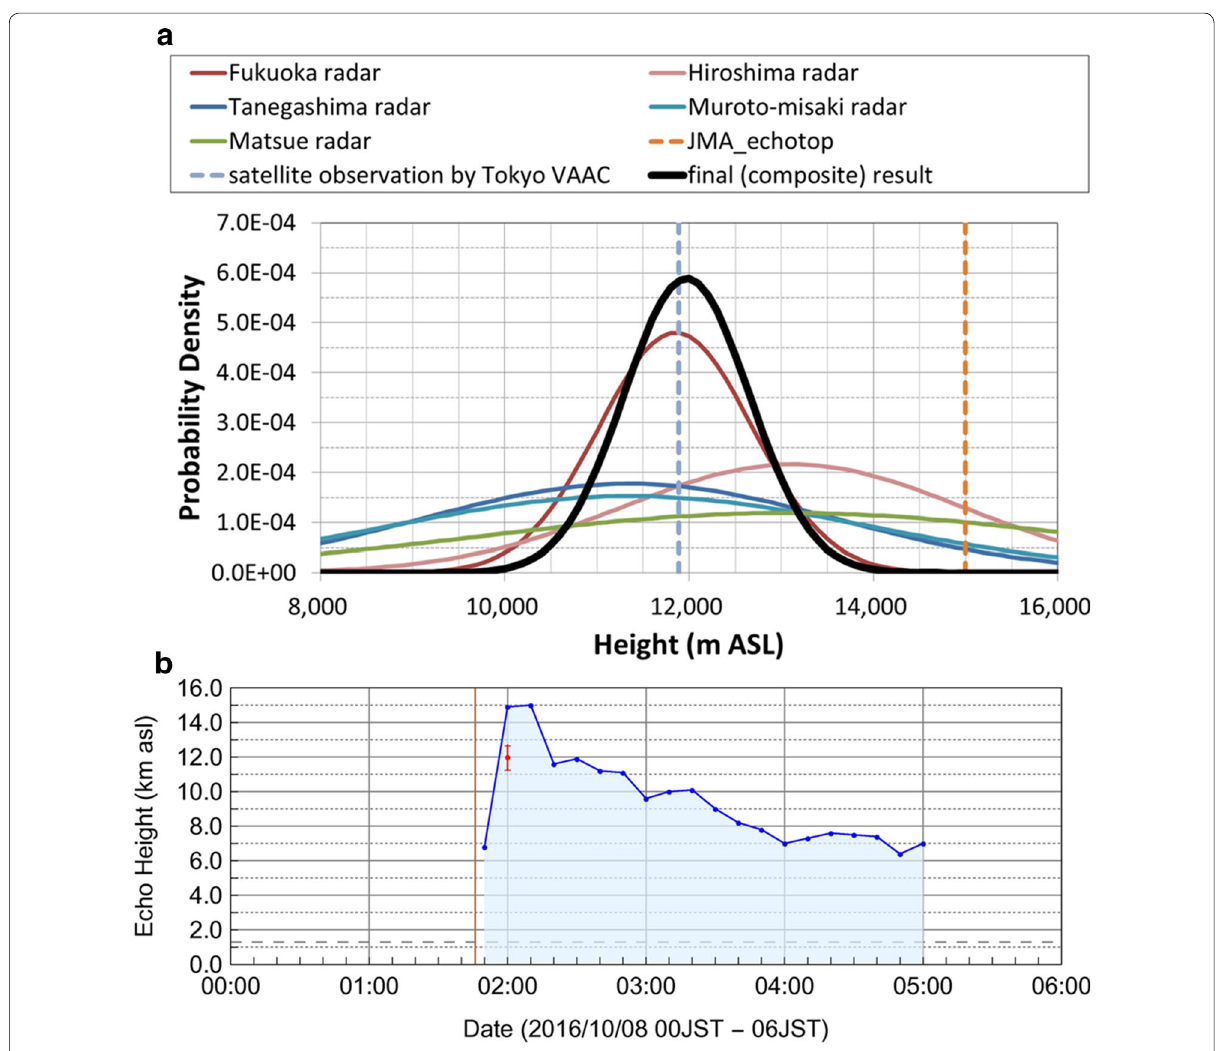
Fig. 5 a Result of probabilistic echo height estimation and b sequential radar echo heights by JMA. In a , the x-axis plots height (m ASL) and y-axis plots probability density. Black solid line represents the composite probability density, estimated by the data from 1:50 to 2:10 JST, October 8, 2016. In b , the x -axis shows the date (JST) and the y -axis shows echo height (km ASL). The red dot and error bar indicate the result of the probability estimation and its 1 σ (68.3%) range. The blue dots show JMA radar echo